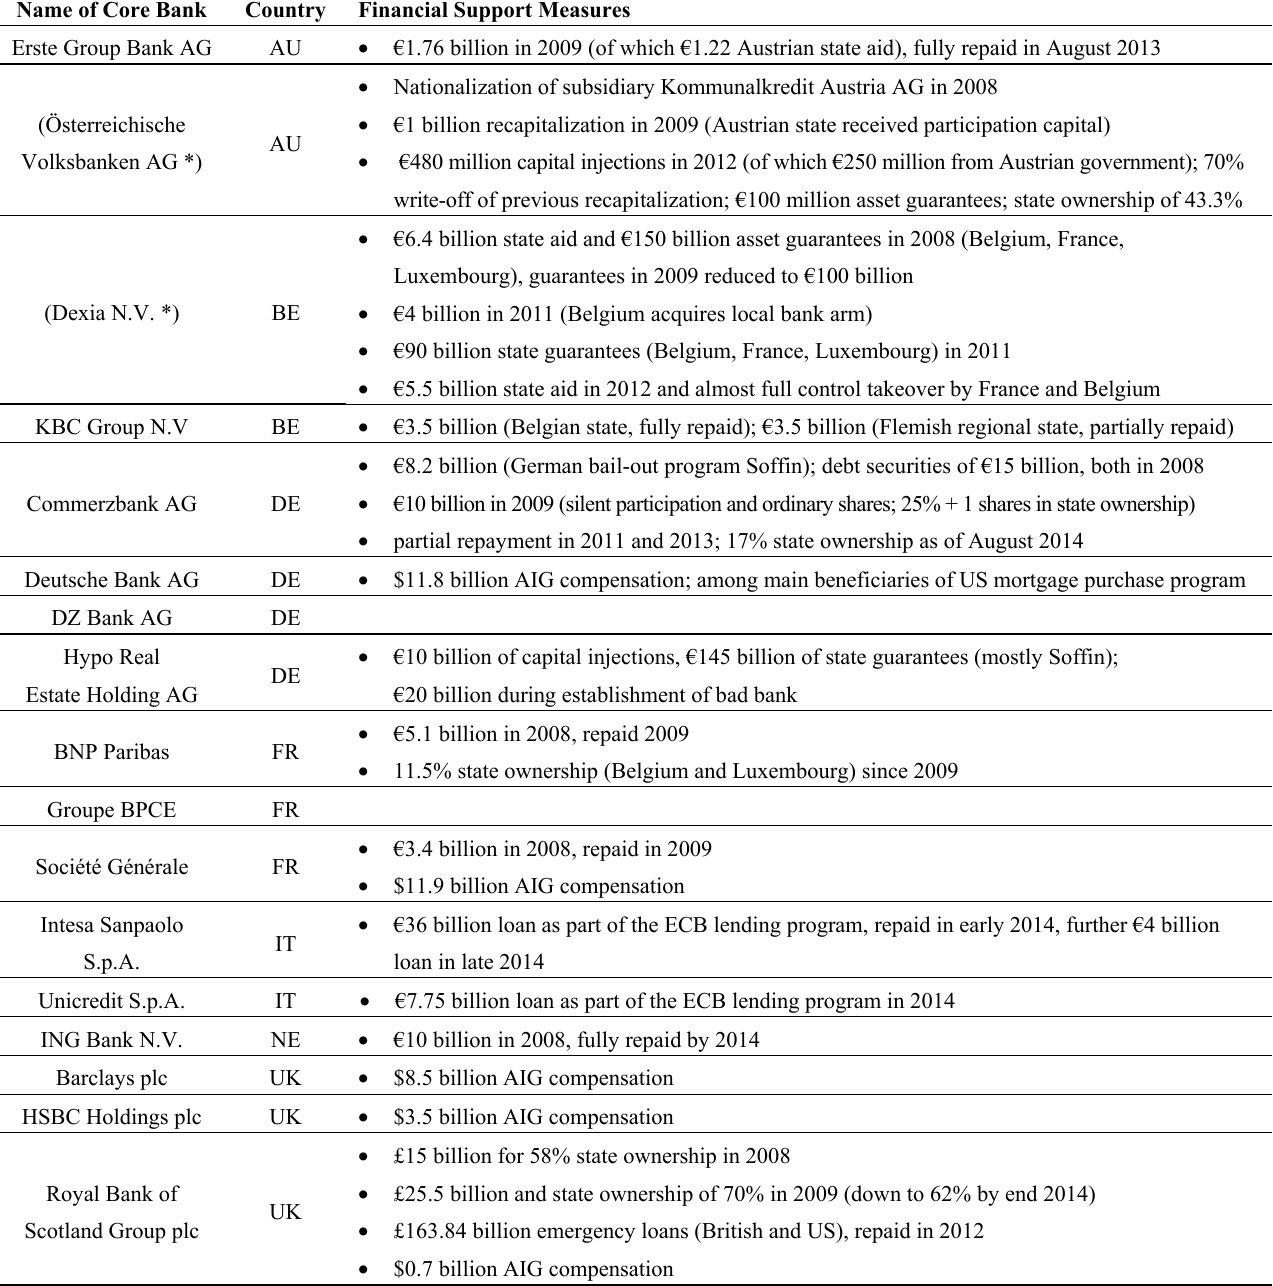
Table 3. List of Major Financial Support Measures received by Core